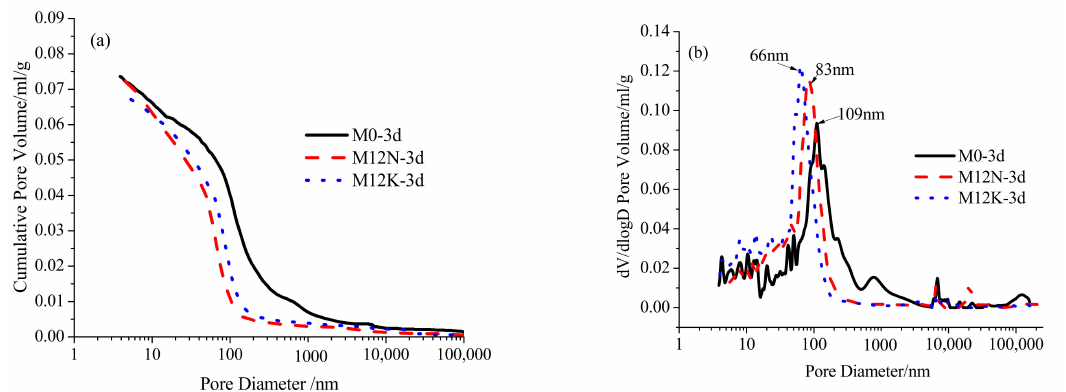
Figure 10. The curves of cumulative pore volume ( a ) and pore size distribution ( b ) of MHPC mortars with different alkali sulfates contents at 3 d.